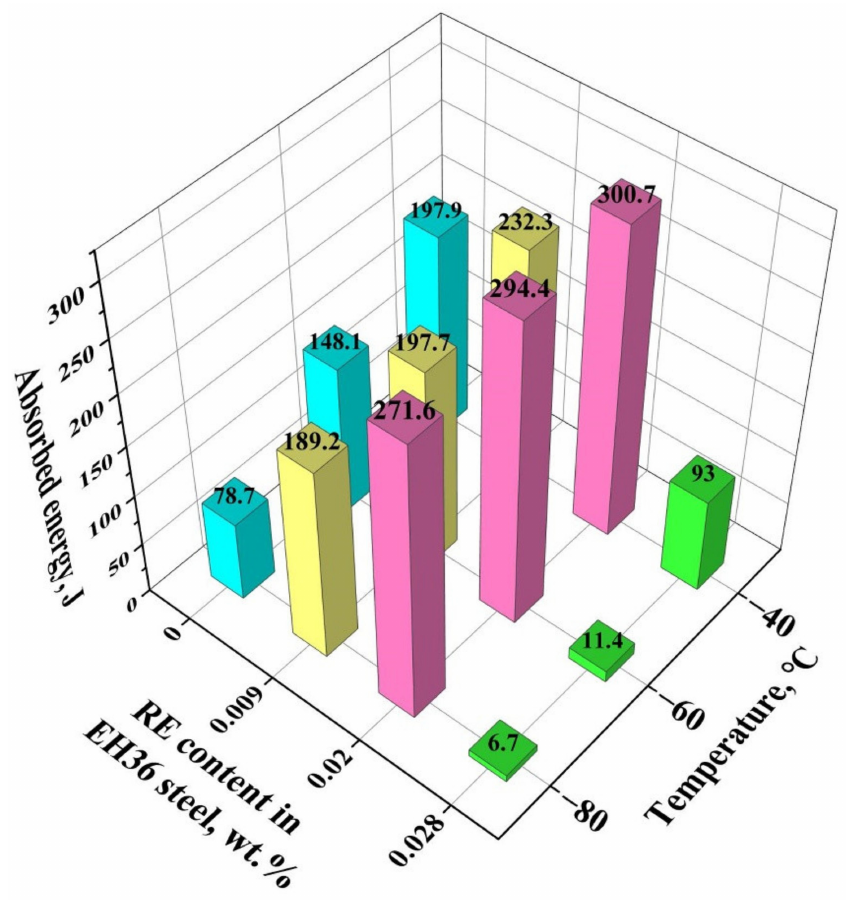
Figure 11. Comparison of cryogenic temperature impact properties of test